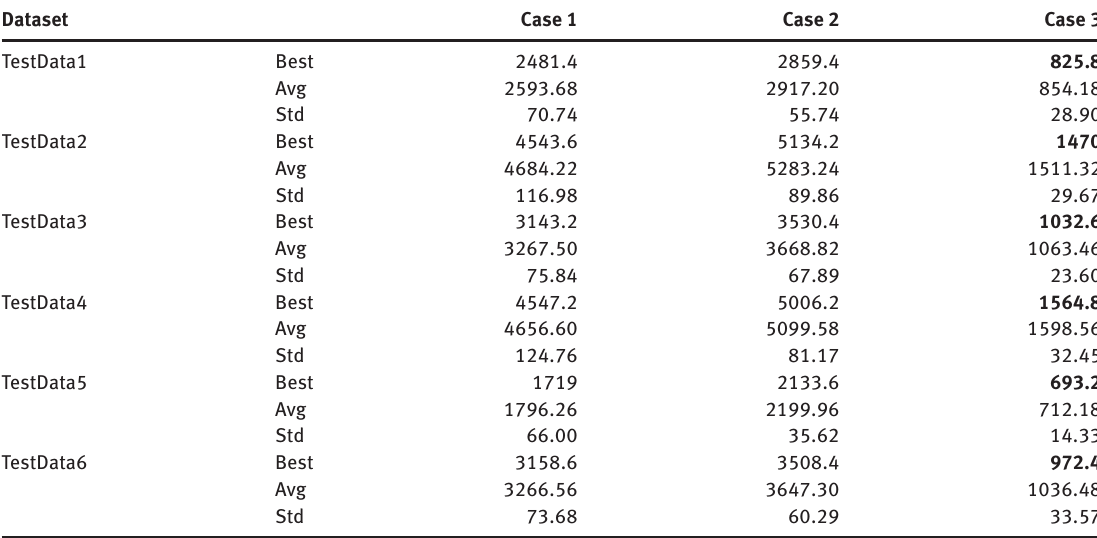
Table 4: Results of Studying HMCR Parameter. Dataset